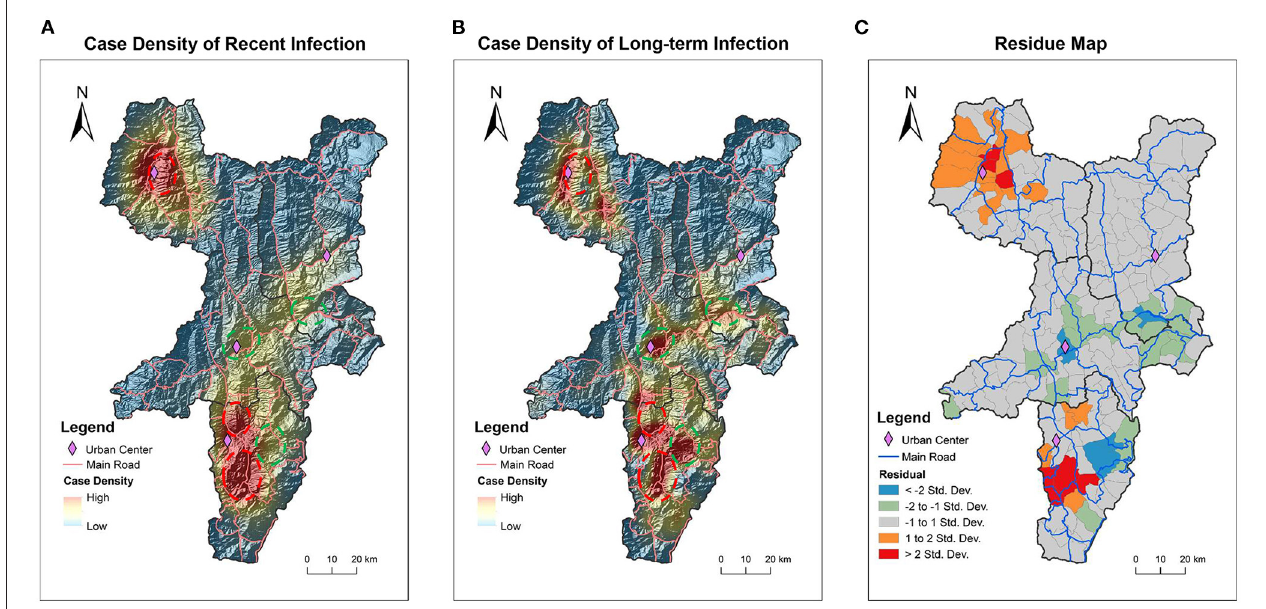
FIGURE 3 | Difference in geographic distribution patterns of recent and long-term infection cases. Kernel density of recently infected HIV cases (A) and long-term infected HIV cases (B) was calculated and mapped on topographic maps. The value of density is displayed through a gradient colormap and the altitude terrain is shown through shading. Dashed red rings encircle the areas showing obviously higher kernel density of recent infection than long-tern infection. Dashed green rings encircle the areas showing obviously lower kernel density of recent infection than long-tern infection. The statistically calculated residuals from OLSR were mapped to visualize the spatial variation between recent and long-term infection (C) . The areas indicated by red and orange have higher kernel density of recent infection, while the areas indicated by blue and green colors have lower kernel density of recent infection. The areas in gray have no difference in kernel density between recent and long-term infection. County borders are indicated by black lines. Town borders are indicated by gray lines, and main roads are indicated by blue lines.